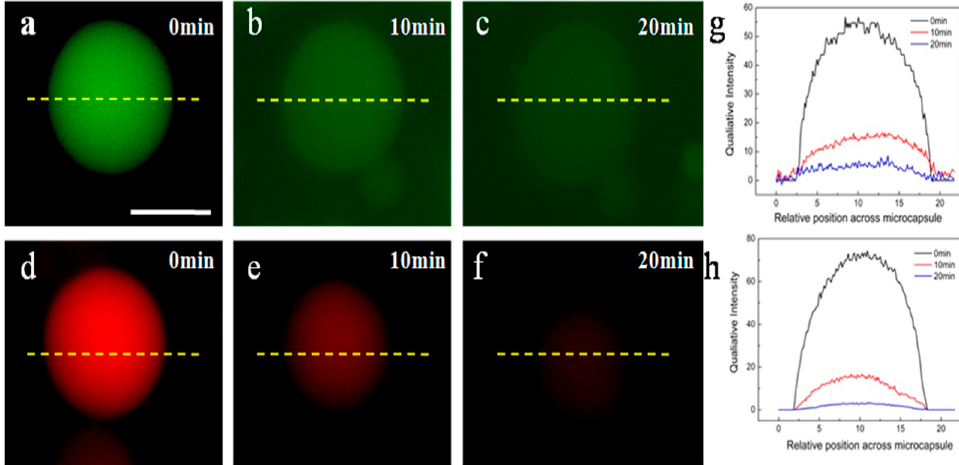
Figure 4. ( a – f ) Fluorescence microscopy image of HPs at different time in the presence of 1 × 10 − 2 M H 2 O 2 . ( g , h ) Corresponding intensity profiles for single HPs shown in ( a – c , d – f ). Scale bar is 10